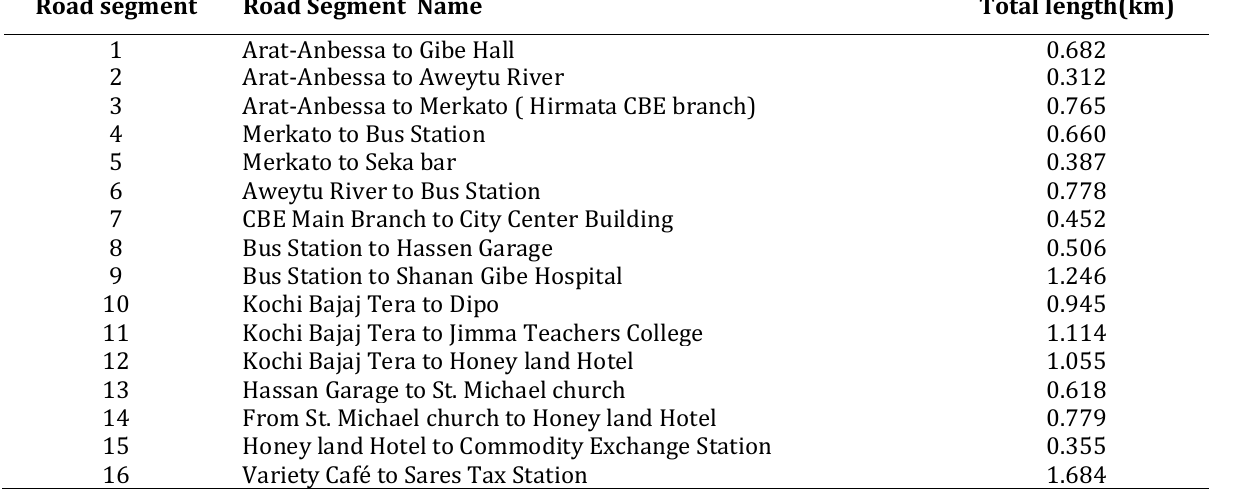
Table 3: Selected road segments with their measured lengths Road segment